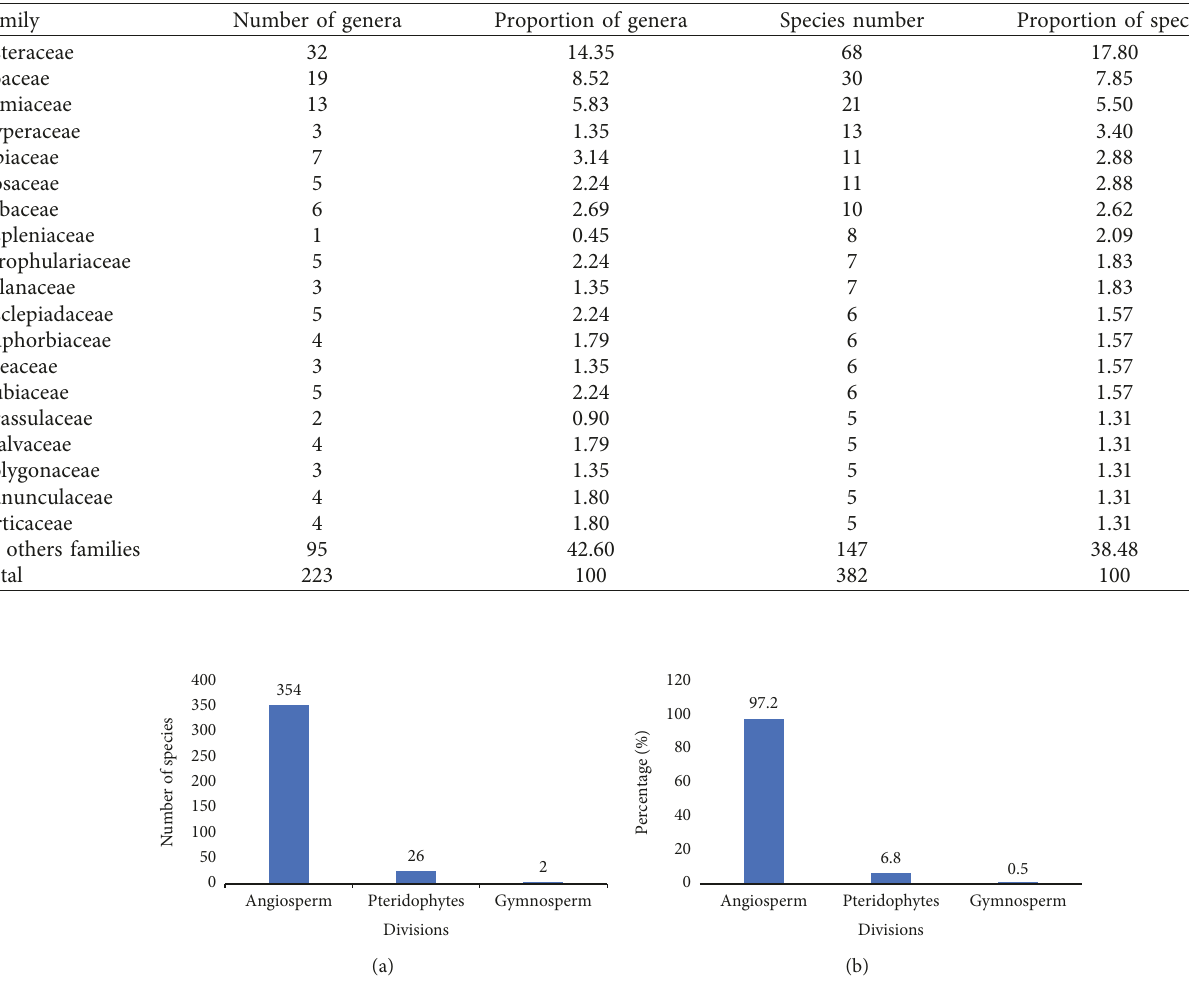
Figure 3: Percentage proportions (a) and number of species (b) of angiosperm, gymnosperm, and pteridophytes of the study